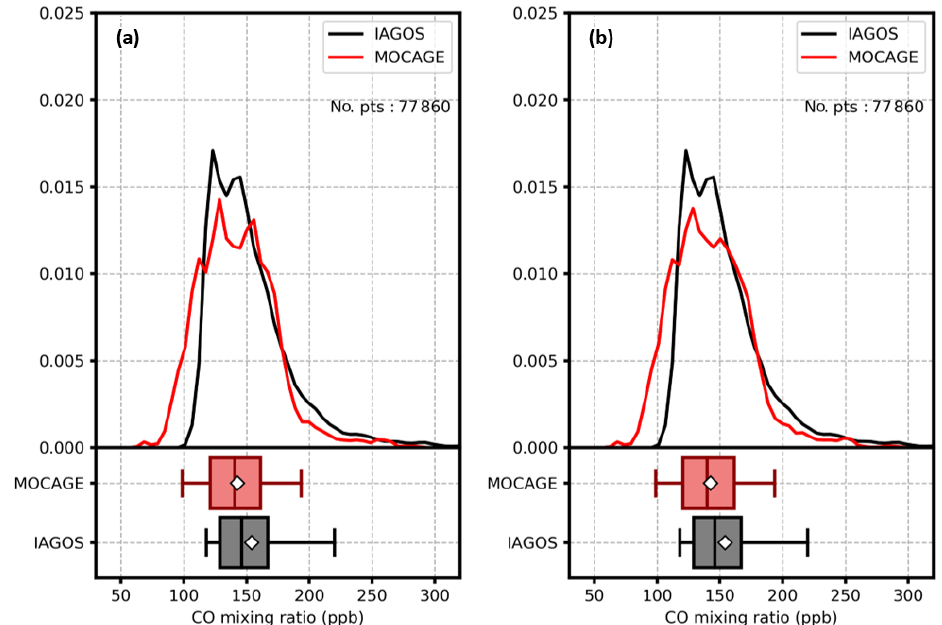
Figure 6. Probability density functions and box plots comparing IAGOS CO mixing ratios (in black) inside identified African biomass burning plumes and corresponding MOCAGE simulated CO mixing ratios (in red) from the (a) BASE simulation and (b) INJH simulation. Whiskers on box plots represent the 5th and 95th quantiles, and the white diamond is the arithmetical mean.